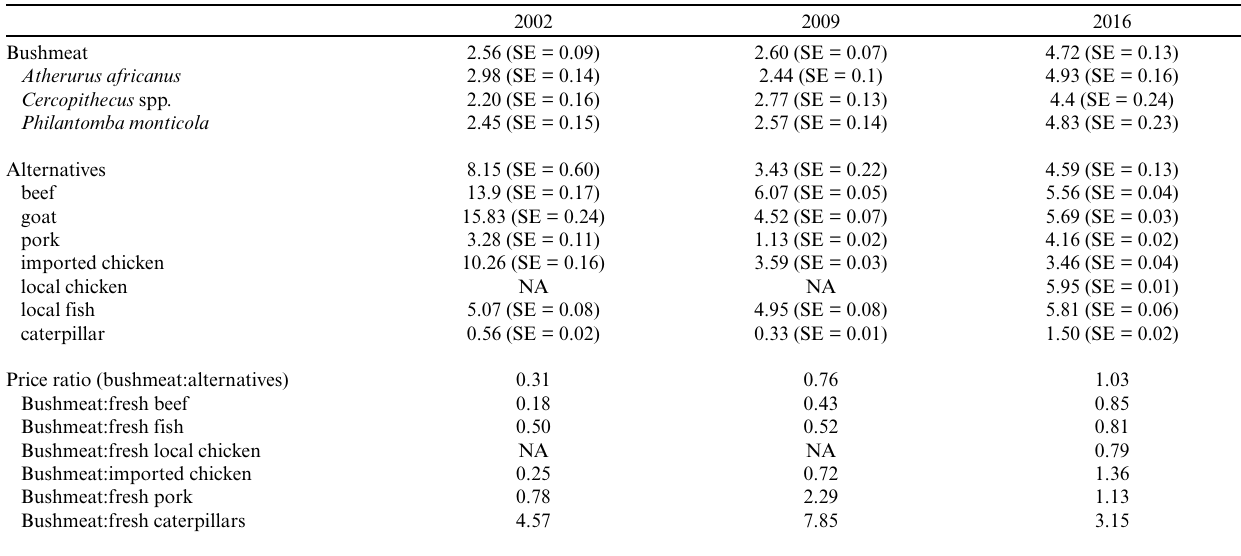
Table 2 . Mean prices for bushmeat and alternative animal protein sources (in US$, showing mean and standard error) and the relative affordability of bushmeat compared with alternative animal protein sources. All ratios are expressed as mean price in US$ per kg of equivalent fresh bushmeat and respective alternative source of animal protein